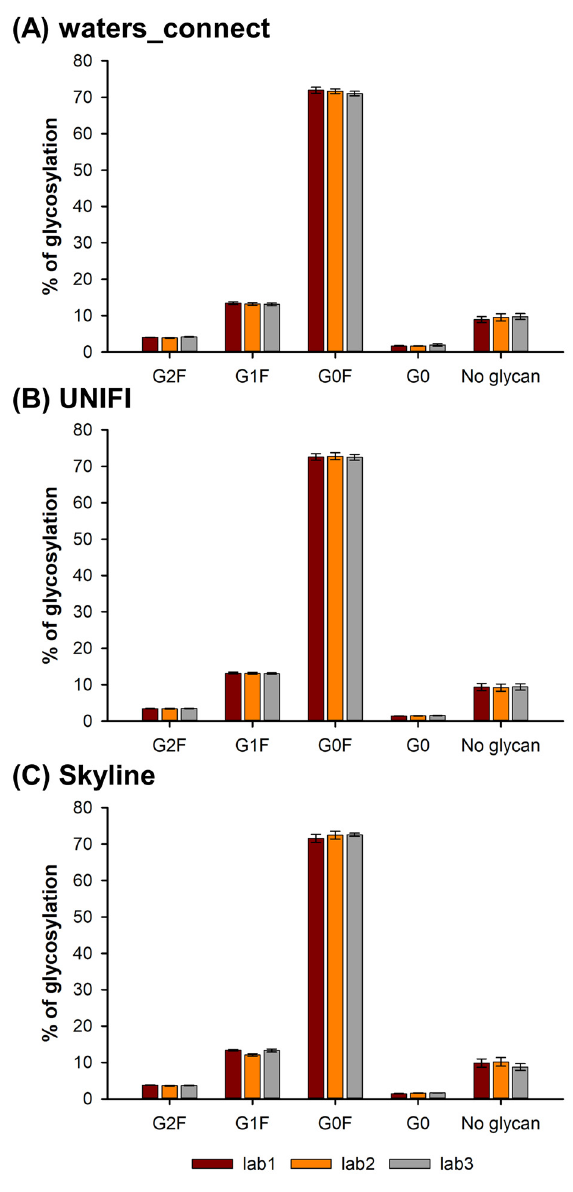
Figure 5. Amounts of G0, G0F, G1F, G2F and non-glycosylated species observed on the TKPREEQFNSTYRVVSVLTVLHQDWLNGK peptide by the three different laboratories (lab1, lab2 and lab3), and by using three different software solutions for data treatment, namely ( A ) waters_connect, ( B ) UNIFI and ( C ) Skyline.